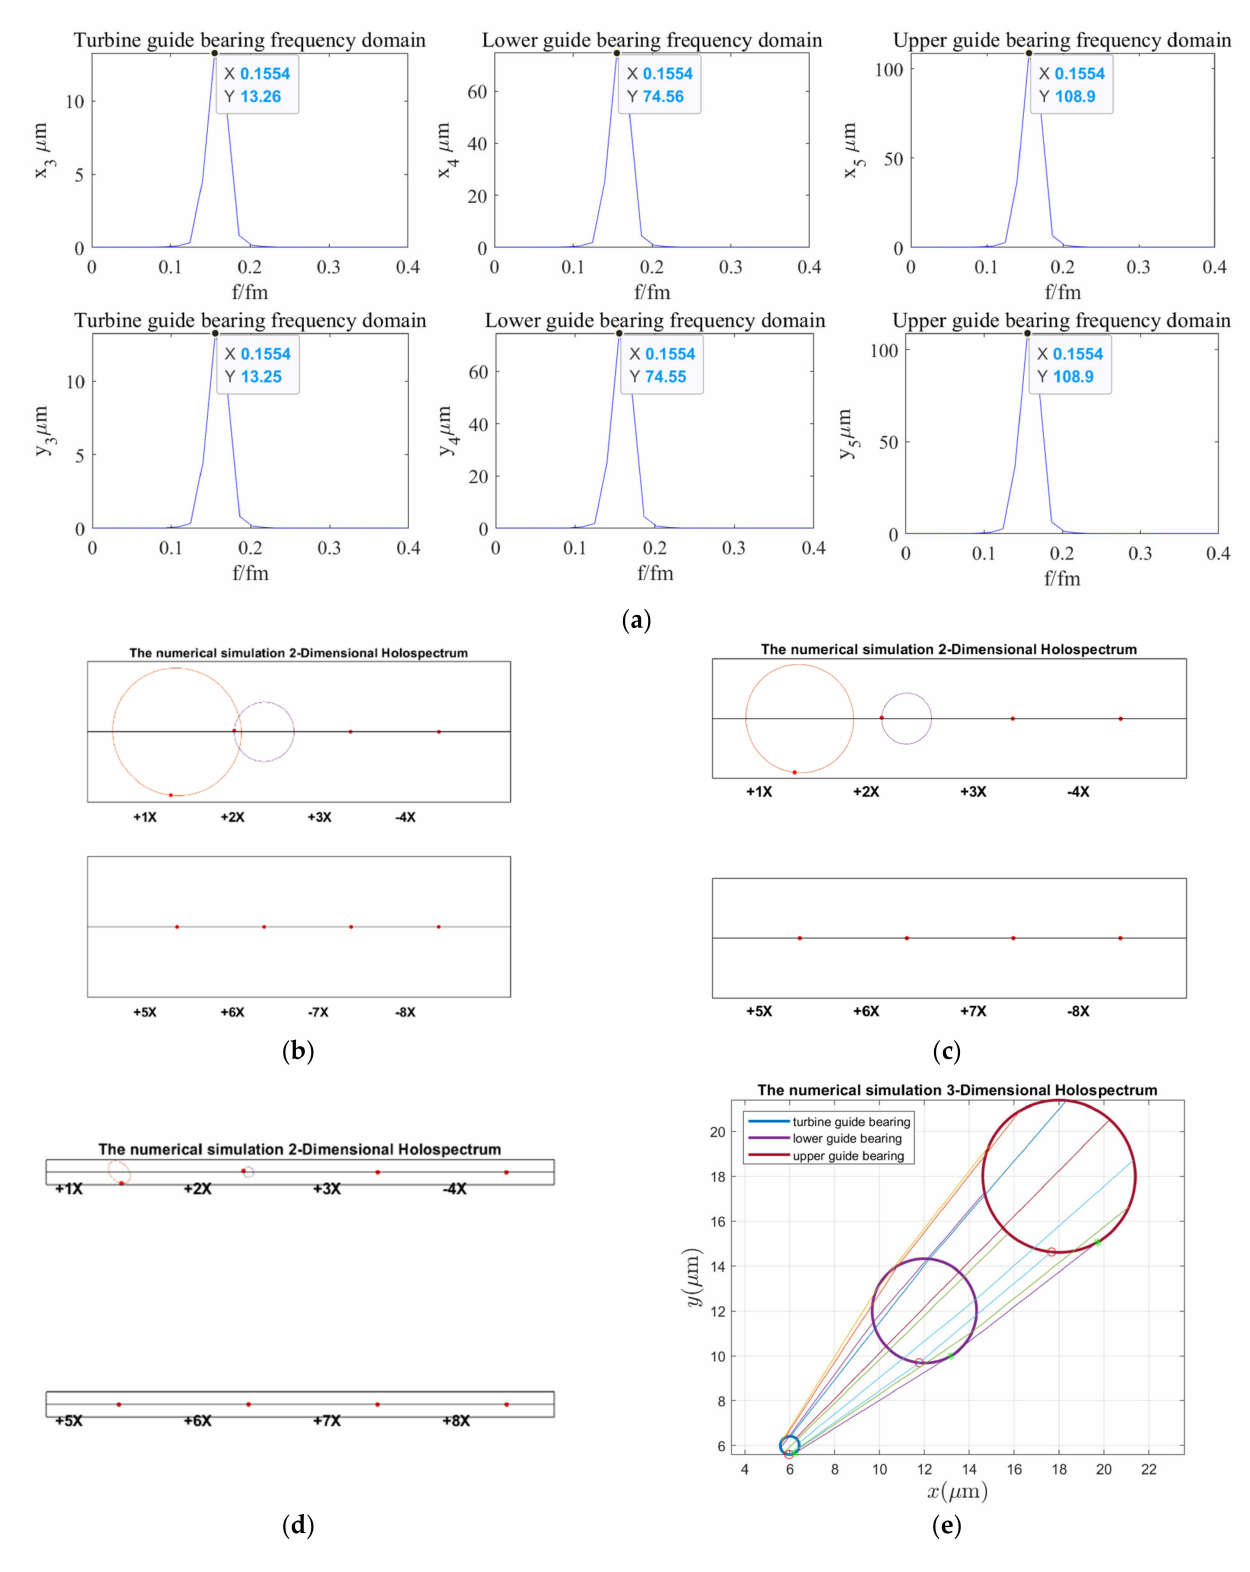
Figure 13. Holospectrum of shafting vibration of misaligned unbalance rotor: ( a ) Shafting vibration spectrogram, ( b ) Upper guide bearing 2D holospectrum, ( c ) Lower guide bearing 2D holospectrum, ( d ) Hydro-turbine guide bearing 2D holospectrum, ( e ) One-fold frequency 3D